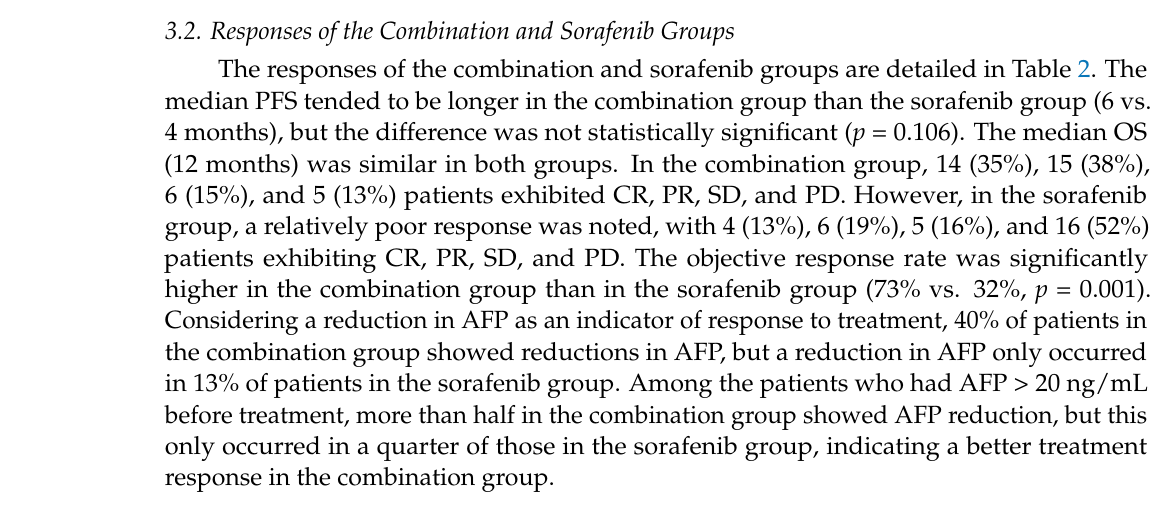
Table 2. Efficacy of and Response Rates for Sorafenib and HAIC-Sorafenib